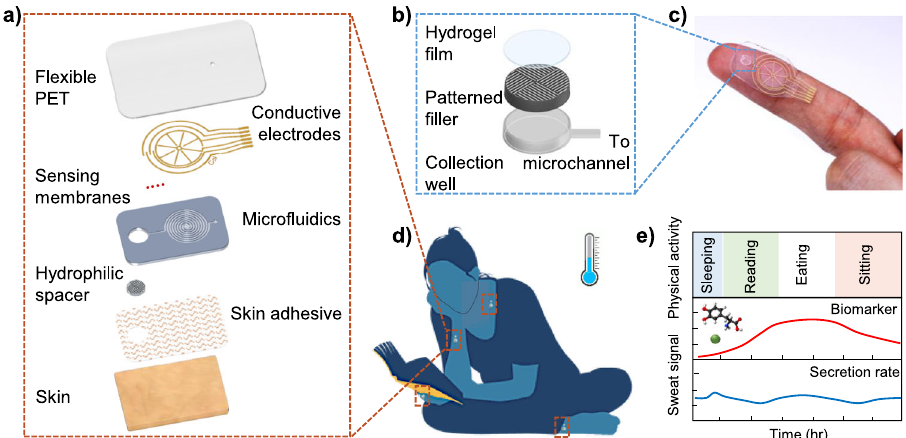
Fig. 1 A schematic of the design, structure, and usage of the micro fl uidic sweat analysis patch. a The patch contains multiple layers. It interfaces the skin via a skin adhesive, and sweat is collected by assistance of hydrophilic fi ller into the micro fl uidics and eventually measured using sensing electrodes fabricated on a thin PET. b The hydrophilic fi ller includes a patterned SU8 mold covered with PVA fi lm and AG-GLY hydrogel and is embedded inside the collection well. The fi ller enhances sweat collection by lowering sweat secretion pressure and taking up volume of the well otherwise will need to be fi lled. c An optical image of the sweat patch on a user ’ s fi nger is displayed. d The patch can be worn on various locations and is used to monitor sweat dynamics without interrupting routine activities. e It can continuously monitor both sweat secretion rate and compositions for long-term without external sweat stimulation, as schematically shown using model